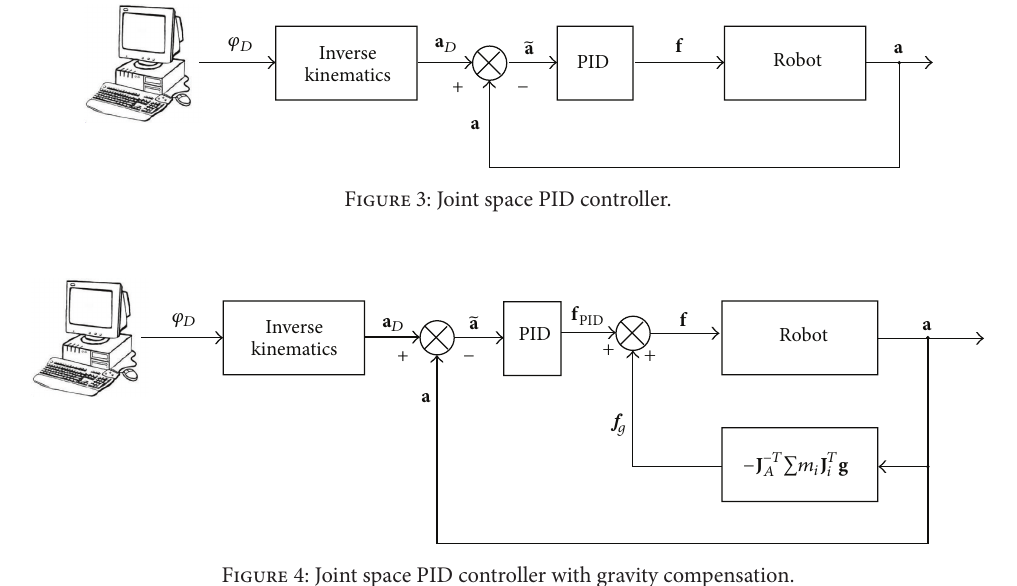
Figure 4: Joint space PID controller with gravity compensation.